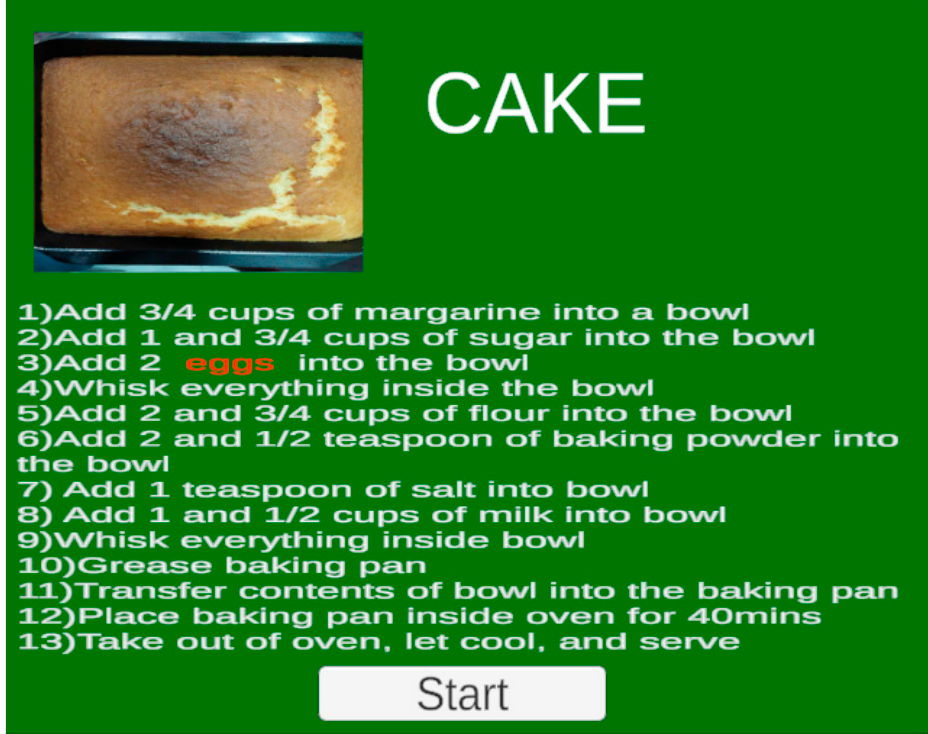
Figure 5. Overall screen showing the recipe for white cake.